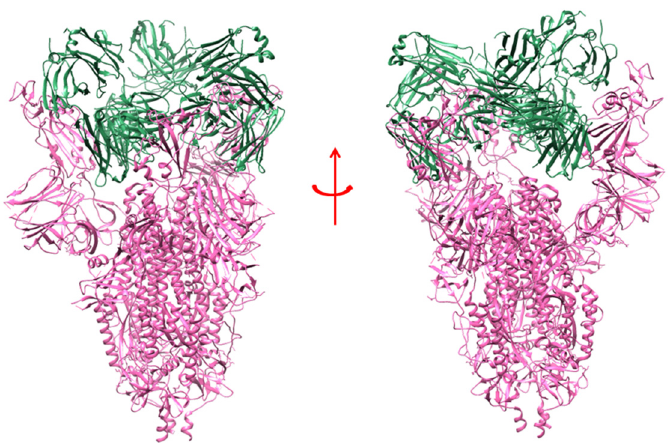
Figure 7. The SARS ‐ CoV ‐ 2 S ‐ protein in a complex with a nAb EY6A Fab [PDB id: